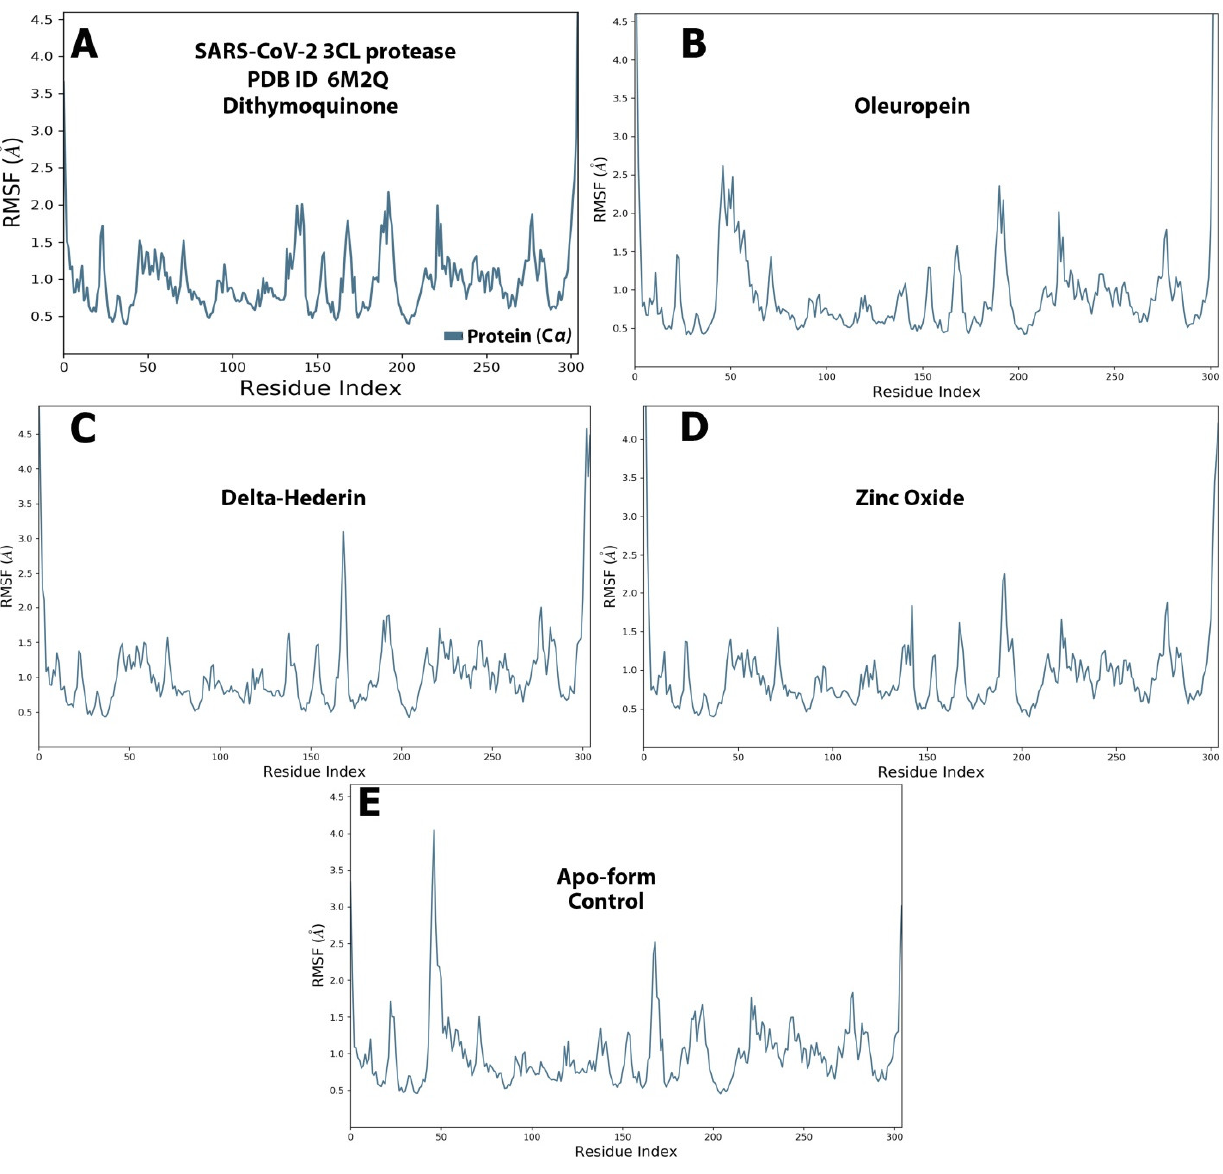
Figure 9. The protein–ligand RMSF of the optimized compounds during the 100 ns. ( A ) dithymo- quinone, ( B ) oleuropein, ( C ) delta-hederin, ( D ) zinc oxide, ( E ) apo-form as a control.